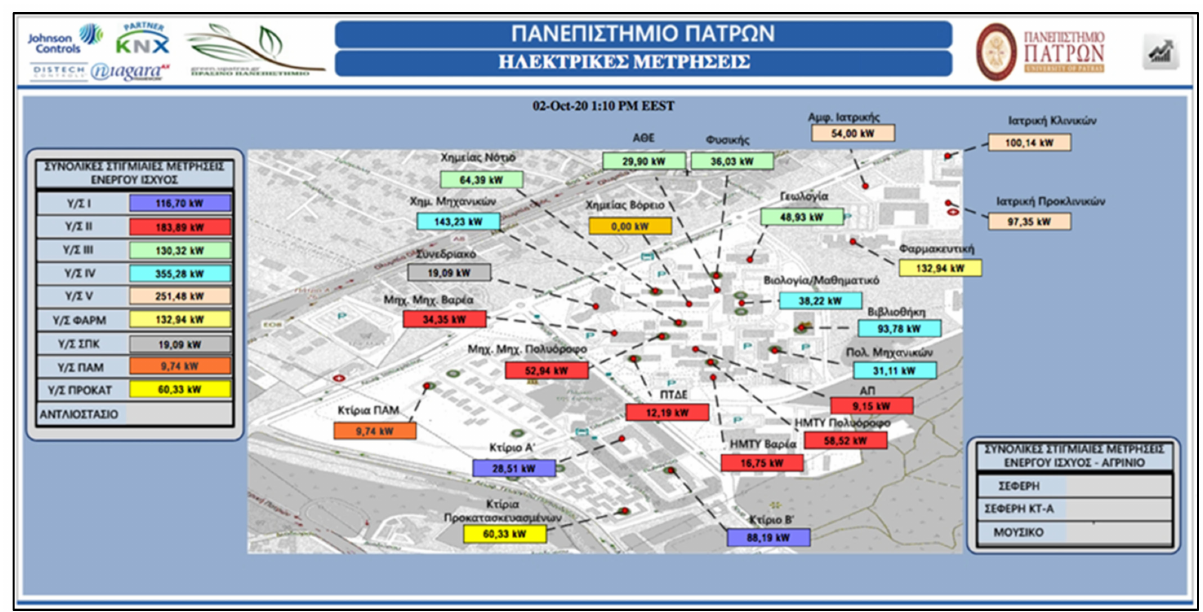
Figure 5. University of Patras’s electricity map. There are nine submetering stations (legend on the left) that track the real-time electricity consumption of all buildings in the campus. The data are controlled centrally from the university’s energy